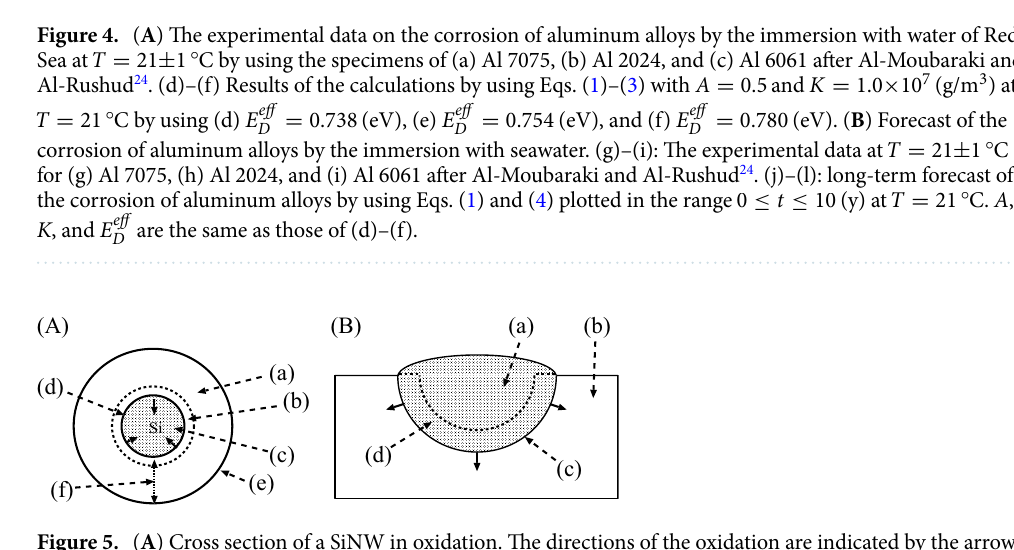
Figure 5. ( A ) Cross section of a SiNW in oxidation. The directions of the oxidation are indicated by the arrows in black. (a) Silicon dioxide. (b) Transition region. (c) Si core. (d) Interface. (e) Oxide surface. (f) Thickness of the oxide. ( B ) Cross section of a pit which is in growth by corrosion. The directions of the growth of the pit are indicated by the arrows in black. (a) Pit. (b) Metal or alloy to be corroded. (c) Interface. (d) Transition